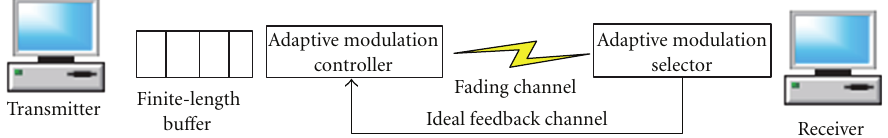
Figure 1: Typical point-to-point tactical wireless